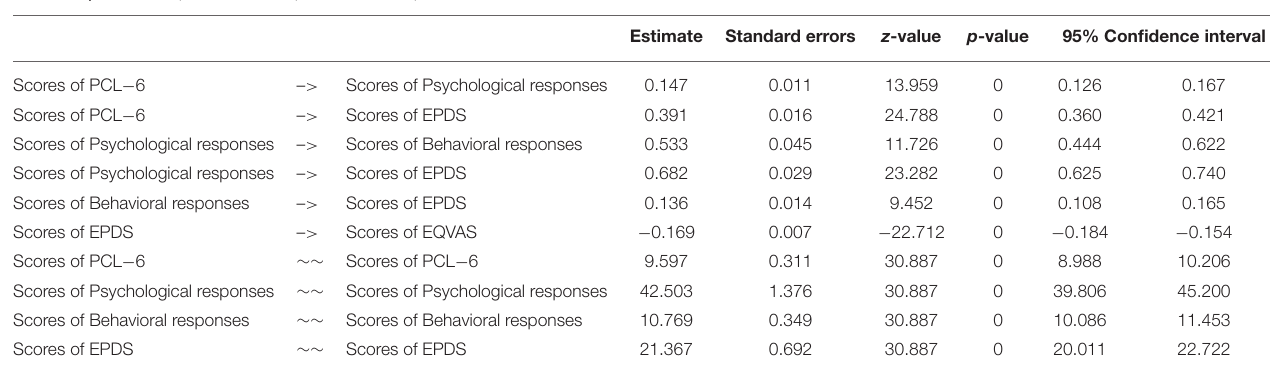
TABLE 4 | Relationship between independent and dependent